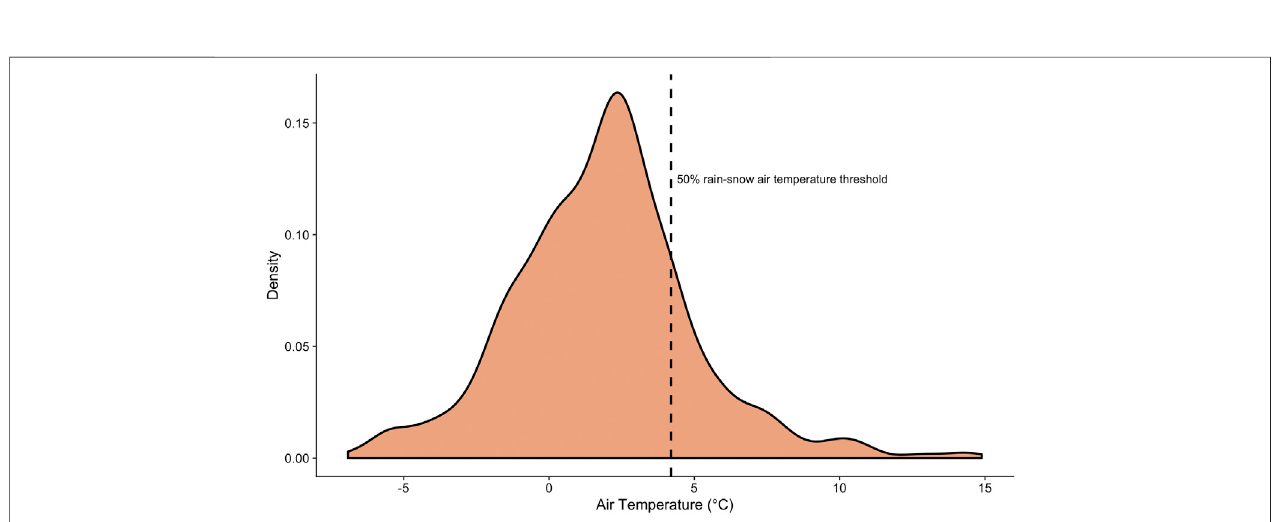
FIGURE 9 | Kernel density plot showing the distribution of all precipitation phase reports by air temperature. The 50% rain-snow air temperature threshold value is marked with the black dashed vertical line. The mean and median air temperature values from our citizen scientist reports were 1.9 and 2.0 ° C, respectively.